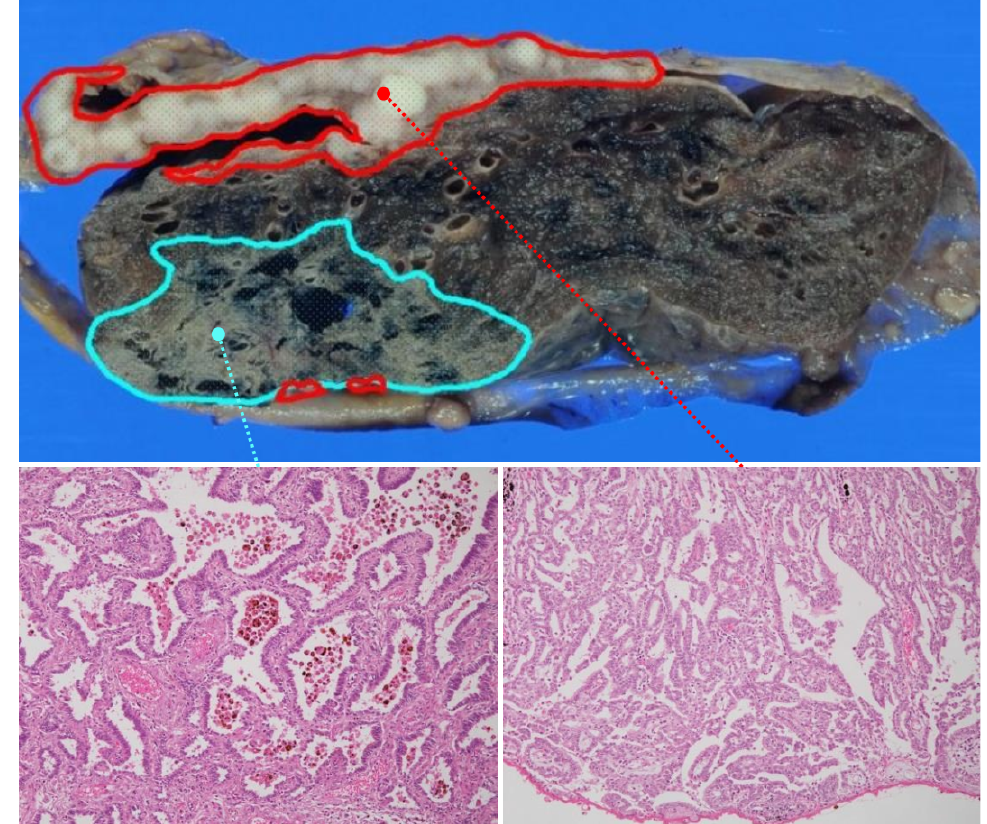
Figure 1. Macroscopy and histology of the synchronous collision tumor consisting of MPM and PAC. Macroscopic and microscopic representation of the tumor. Macroscopically, the lesion appears to consist of the following two components: MPM (encircled by red lines) and PAC (blue lines). Microscopy revealed that these MPM and PAC lesions each exhibited typical histological